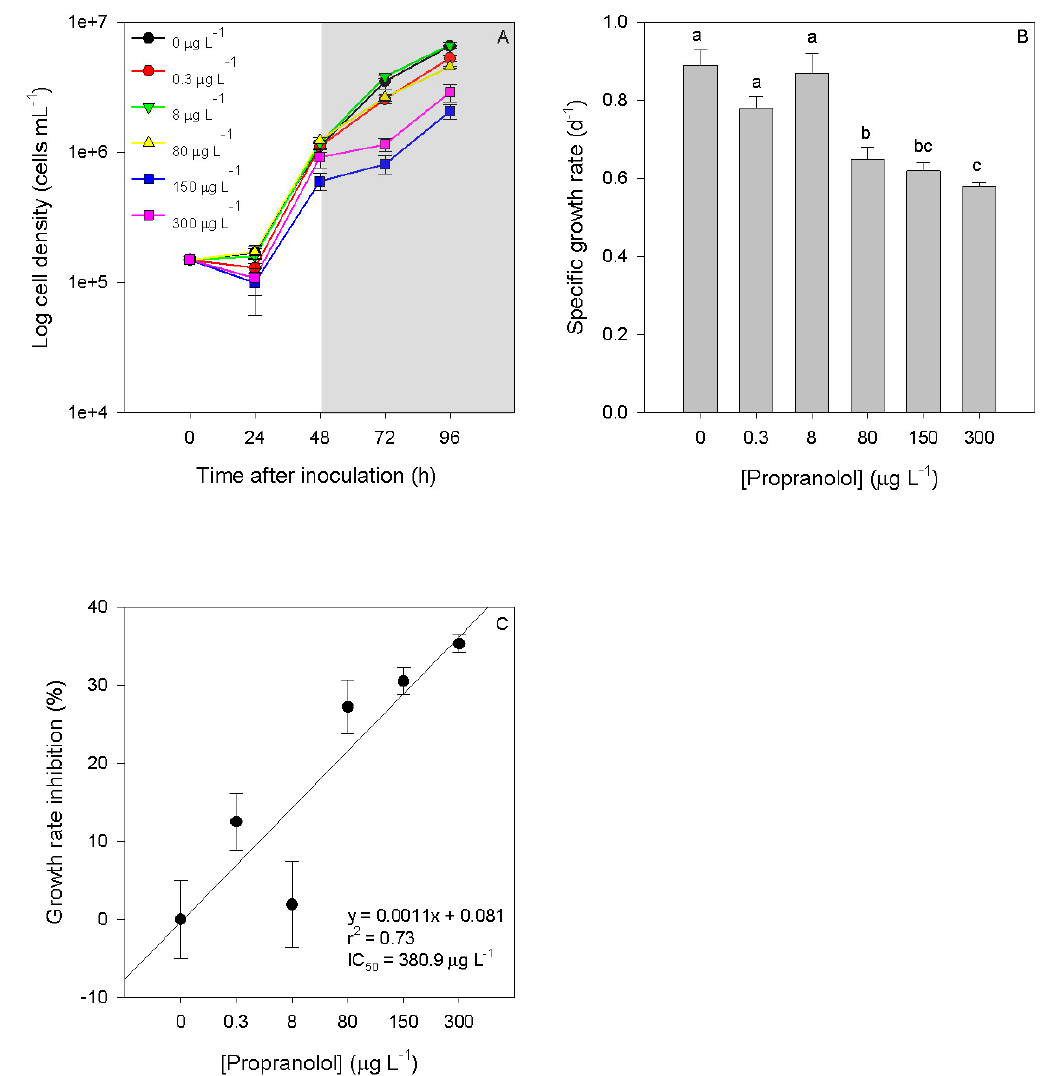
Figure 1. Growth curves (( A ), grey area corresponds to the exposure period), specific growth rate ( B ) and growth inhibition percentages ( C ) of Phaeodactylum tricornutum cultures exposed to different propranolol concentrations (average ± standard error, n = 3, letters denote di ff erences at p <